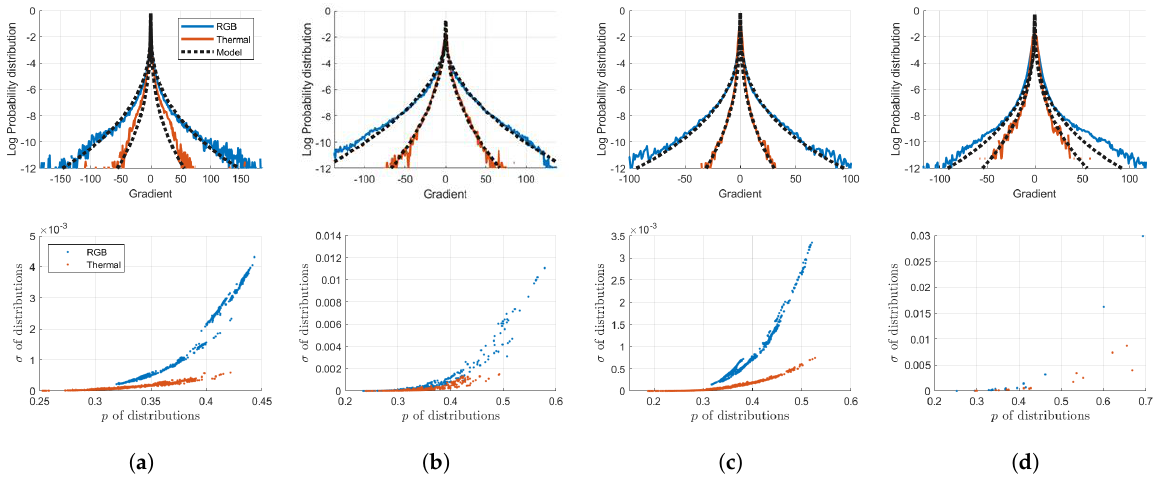
Figure 5. Examples of modeled gradient distributions of the individual RGB and thermal image dataset in Figure 4. The above gradient distributions are approximated to the GGD model with our previous statistical modeling algorithm. The graphs below exhibit the modeled parameters p (horizontal axis) and σ (vertical axis) for each image of the dataset. In the above distributions, the blue and the red lines denote RGB and thermal distributions, and the black dotted lines denote the statistical models describing them. In the graphs below, the blue and the red dots denote the statistical parameters of RGB and thermal images, respectively. ( a ) Trimodal dataset [27]; ( b ) CATS dataset [28]; ( c ) FLIR dataset [29]; ( d ) SRIP dataset